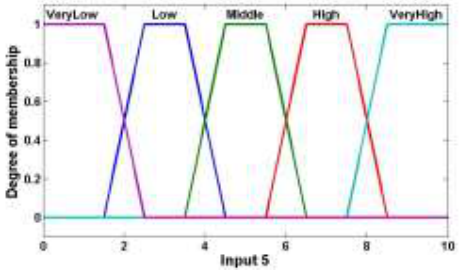
Figure 6. Membership functions of the Input 5